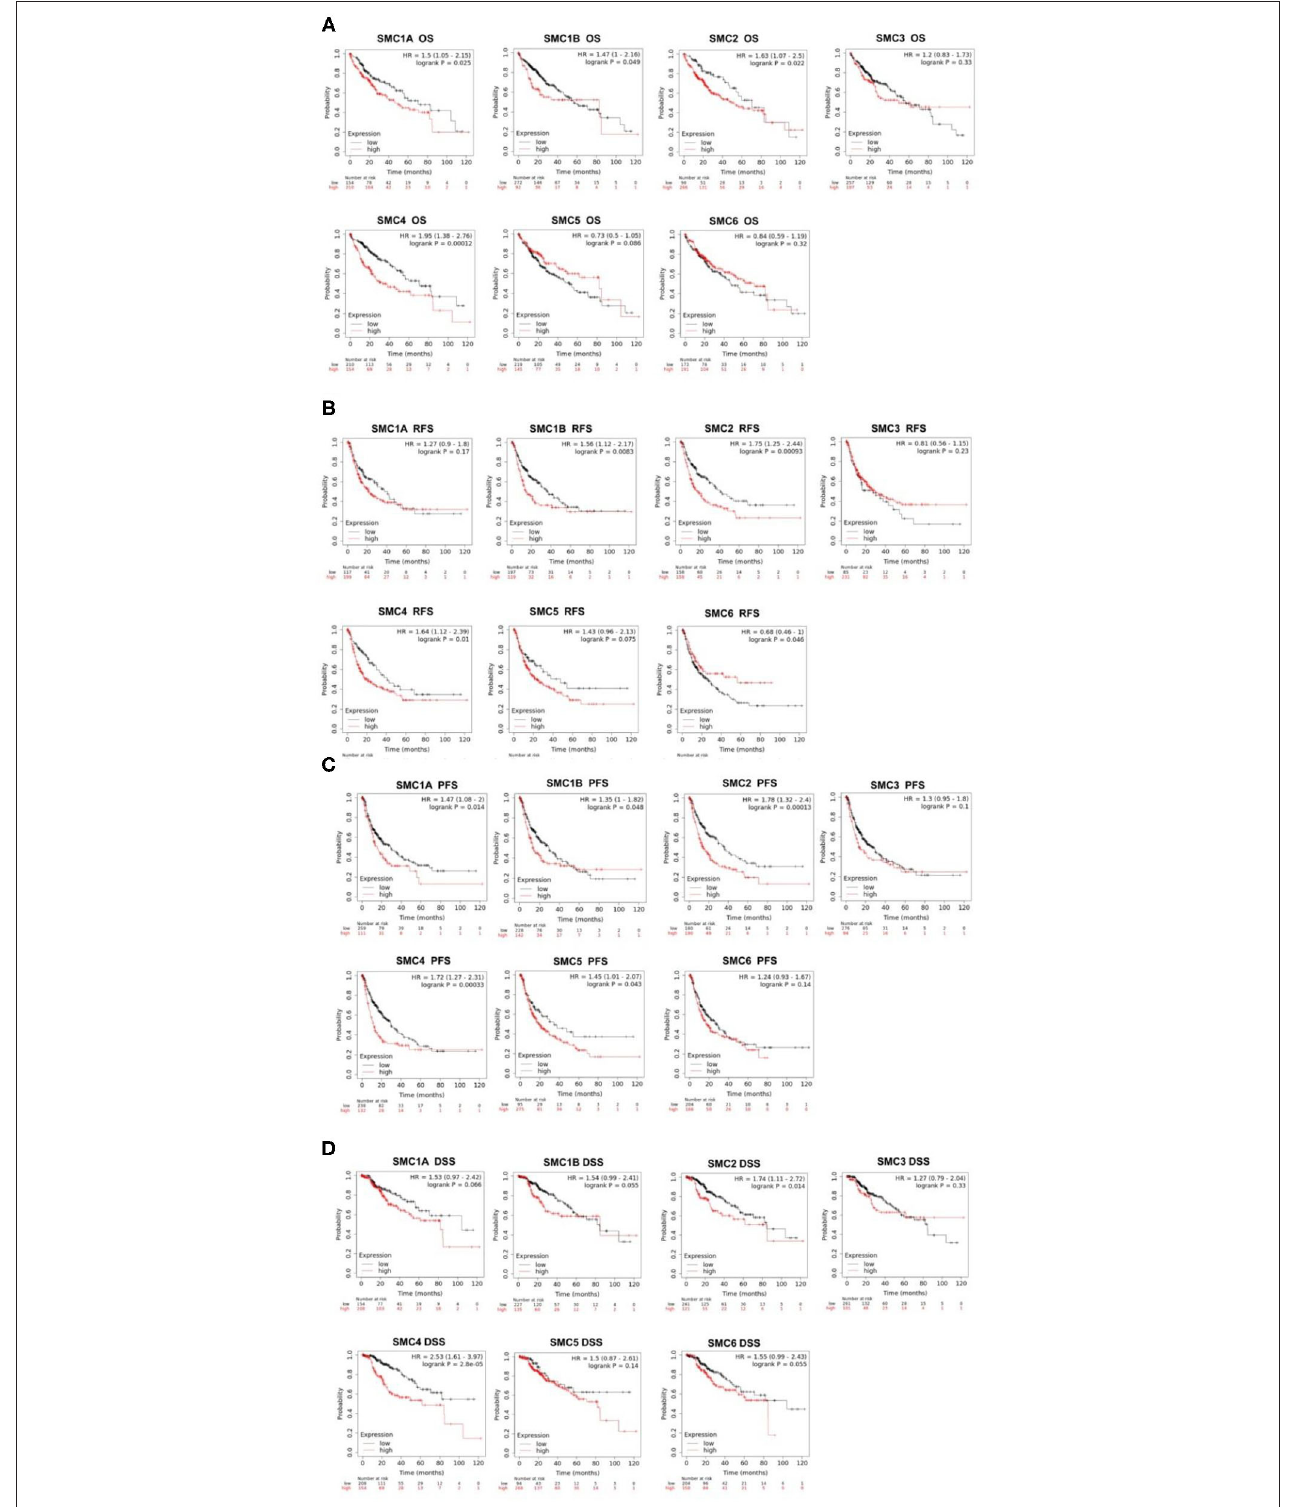
FIGURE 4 | Prognostic value of SMC family in HCC. (A-D) The expression of SMC family members showed significant associations with OS, RFS, PFS, and DSS in HCC, and statistical significance was assessed by log-rank tests.